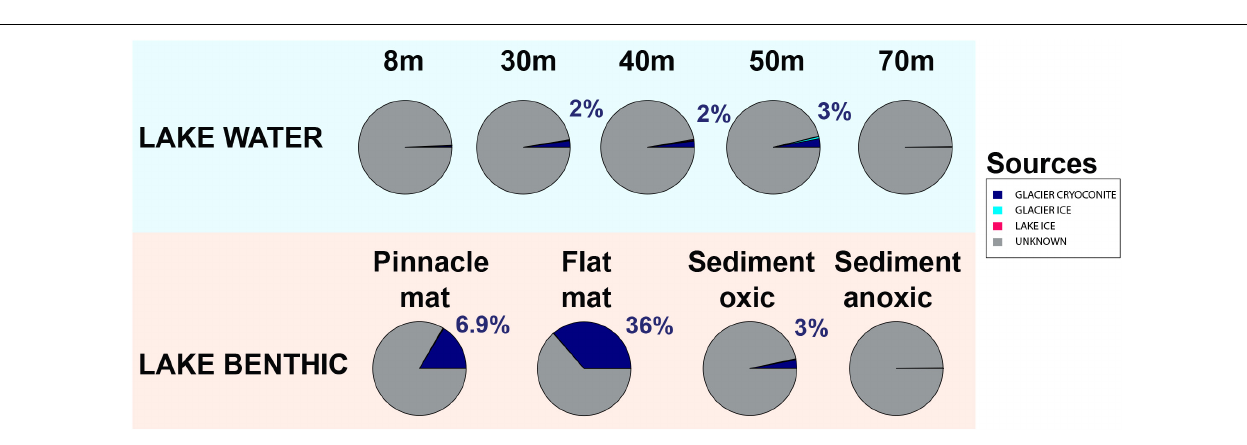
FIGURE 11 | Defining potential sources of the microbial community using the Bayesian community-wide culture-independent microbial source tracking algorithm. Most source environments remained unknown (depicted in gray). Most of the known source environments belonged to the group “GLACIER